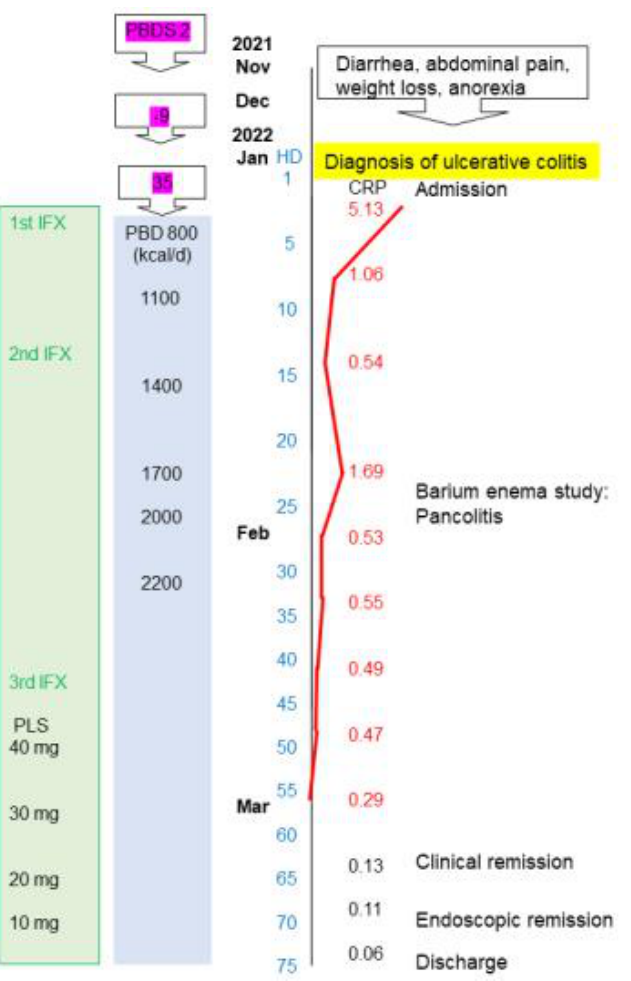
Figure 1. Timeline of the case. IFX, infliximab; PLS, prednisolone; PBD, plant-based diet; PBDS, plant-based diet score; HD, hospital day; CRP, C-reactive protein. Abnormal CRP (normal range ≤ 0.14 mg/dL) levels are shown in red.